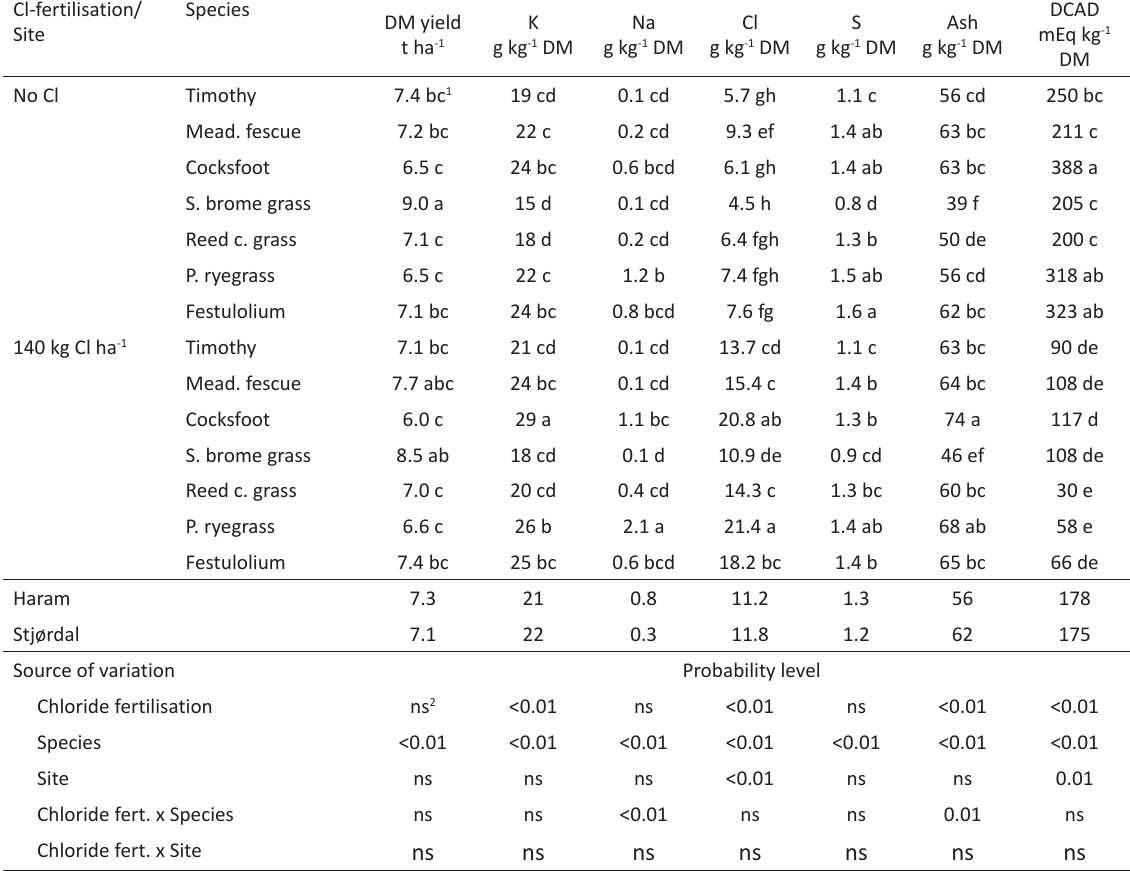
Table 5. Experiment 4: Forage dry matter yield, mineral concentrations and Dietary cation-anion difference (DCAD) at the first cut in the first ley year according to chloride fertilisation and species (average of two sites) and according to site. Cl-fertilisation/ Species DM yield Site t ha